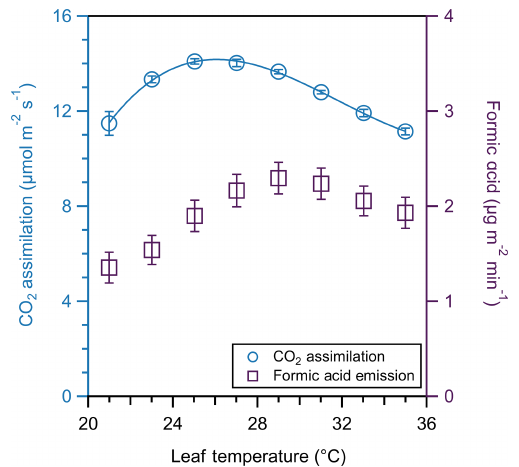
Figure 7. CO 2 assimilation (blue circles) and formic acid emission (purple squares) temperature response curve of one spearmint leaf. Temperatures varied by 2 ◦ C from 21 to 35 ◦ C. CO 2 assimilation follows the expected cubic fit. We collected assimilation and formic acid emission measurements for 5min and averaged the values of each; error bars represent the standard deviation of those